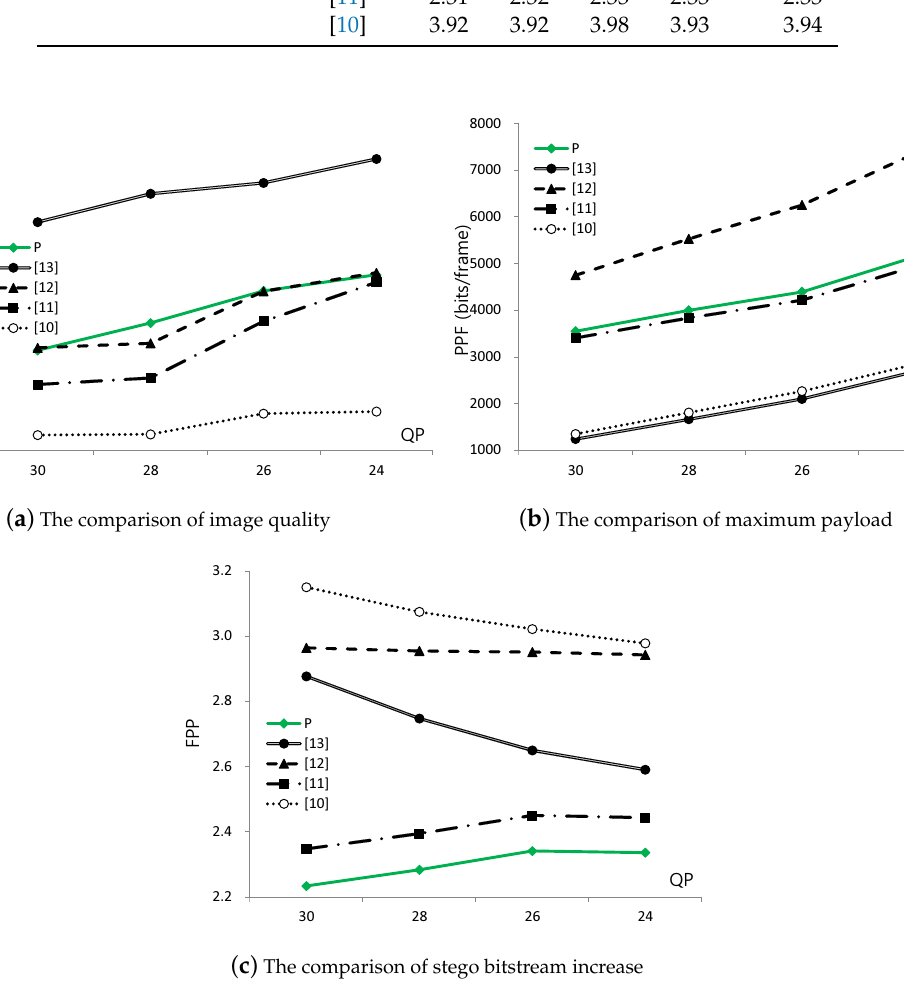
Figure 4. Comparison between our proposed method (P) and the methods of